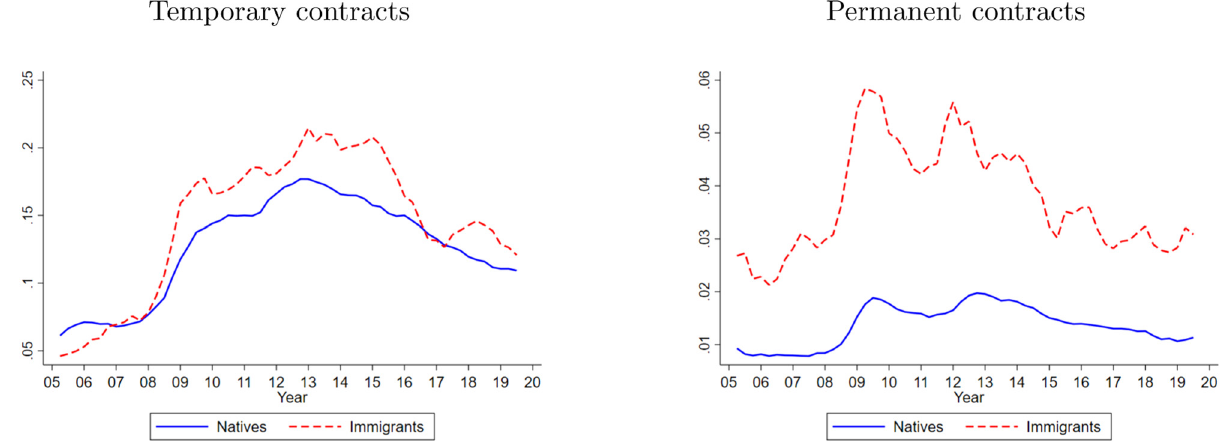
Figure A7: Job - separation rate by nationality and type of contract. Note: The transitions are seasonally adjusted using a 4 - quarters moving average, constructed from the Spanish Labour Force Survey - Flows.